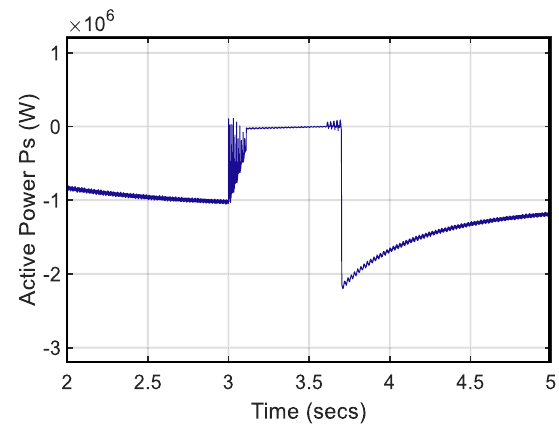
Fig. 22 Evolution of the stator active power